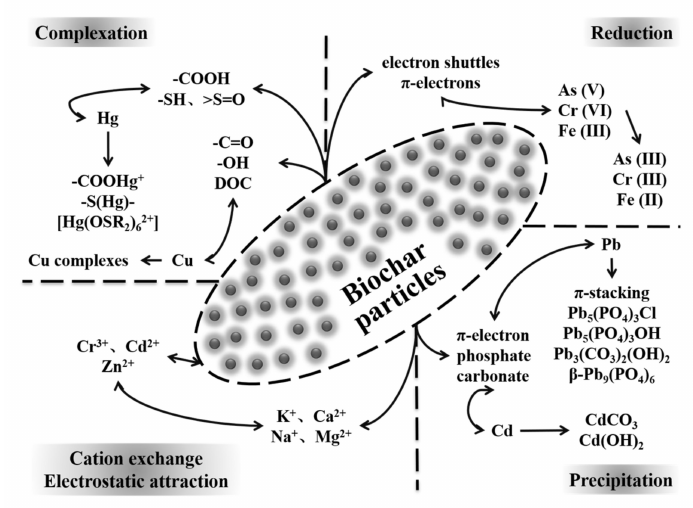
Figure 1. Interaction mechanism between biochar particles and HMs in